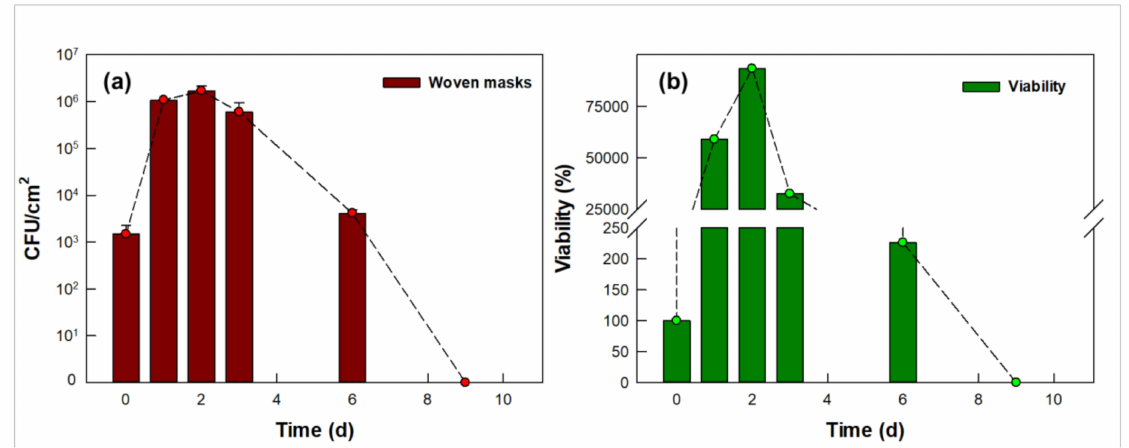
Figure 2. Viability levels of B. subtilis from airborne bioaerosols filtered by a woven face mask. ( a ) Colony forming unit (CFU)/cm 2 values and ( b ) viability rates of the B. subtilis airborne bioaerosols. Error bars represent standard deviation of the data ( n = 9). The dashed line shows a trend of each